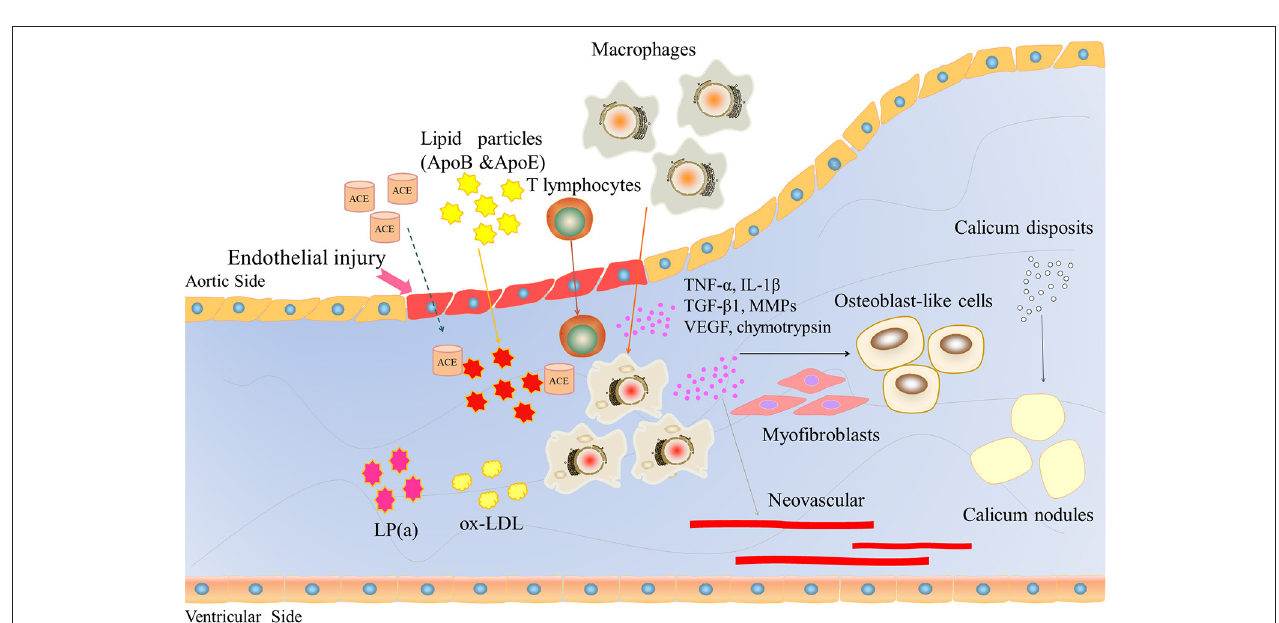
FIGURE 1 | The structure of aortic valve. Macroscopically, the normal aortic valve is roughly divided into two edges, two sides, and three layers: free edge and basal edge, aortic surface and ventricular surface, ventricular layer, fibrous layer and sponge layer. Microscopically, it is mainly composed of valve endothelial cells and valve stromal cells and extracellular matrix such as collagen, glucan, and elastin.